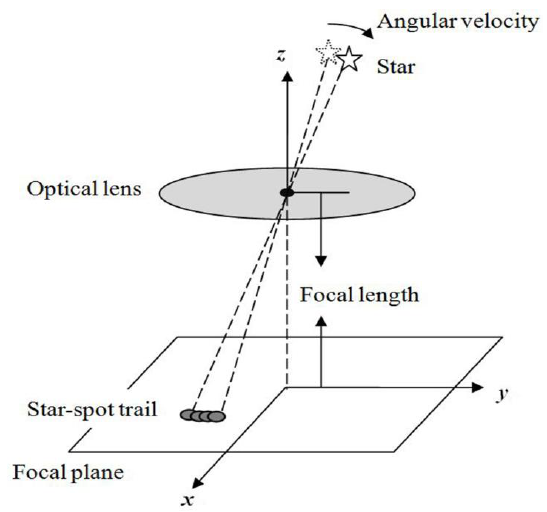
Figure 2. Dynamic star-spot imaging